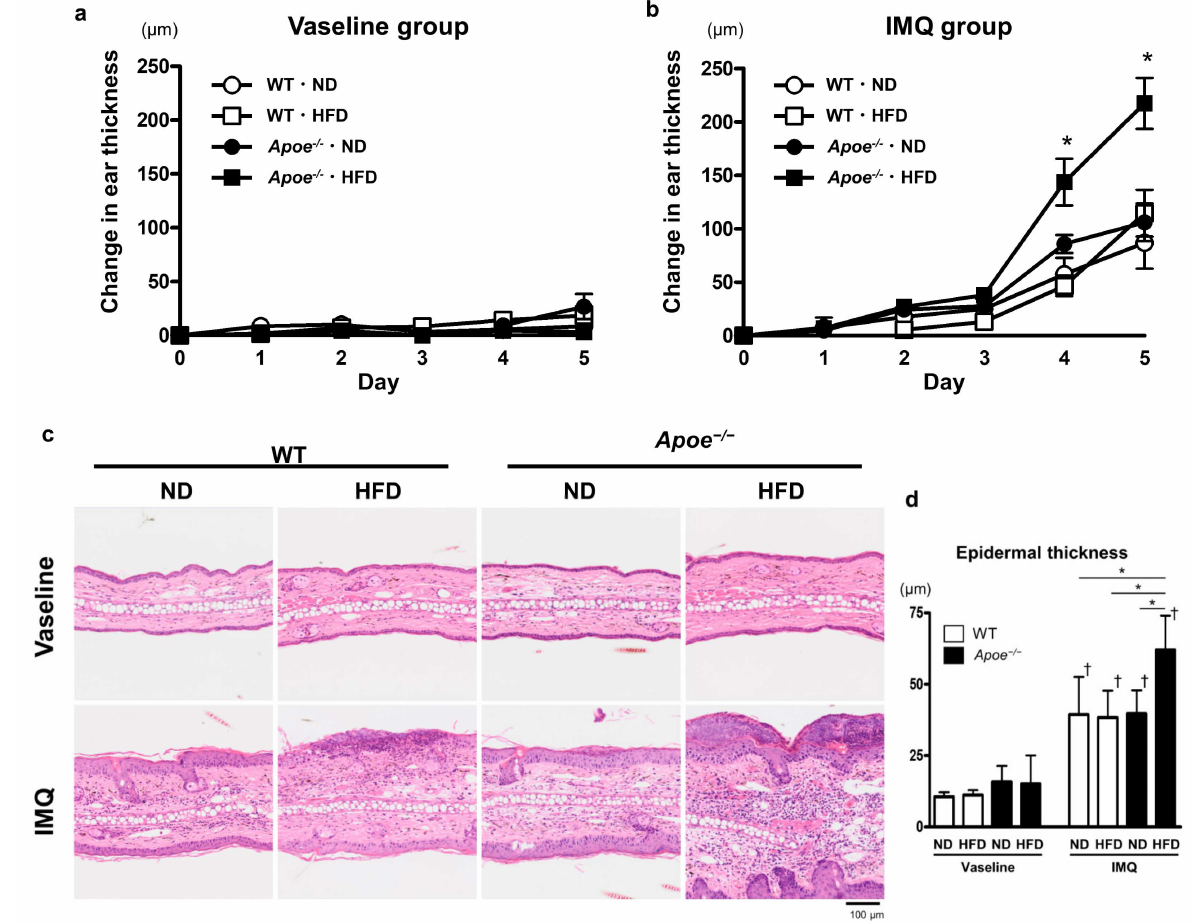
Figure 2. Synergistic effects of obesity and dyslipidemia on psoriatic skin inflammation: ( a , b ) Changes in ear thickness. Wild-type and Apoe − / − mice were fed with a normal diet or a high-fat diet and treated with imiquimod cream (25 mg/mouse) or Vaseline (control) ( n = 6 per group). Values are shown as the mean ± standard error of the mean; * p < 0.05, compared to other groups at indicated time points. ( c ) Representative images of hematoxylin- and eosin-stained ears of indicated mice. Bar = 100 µ m. ( d ) Histological analysis of epidermal thickness. Values are presented as the mean ± standard deviation; * p < 0.05, † p < 0.05, compared to Vaseline-treated mice. IMQ, imiquimod; WT, wild-type; ND, normal diet; HFD, high-fat